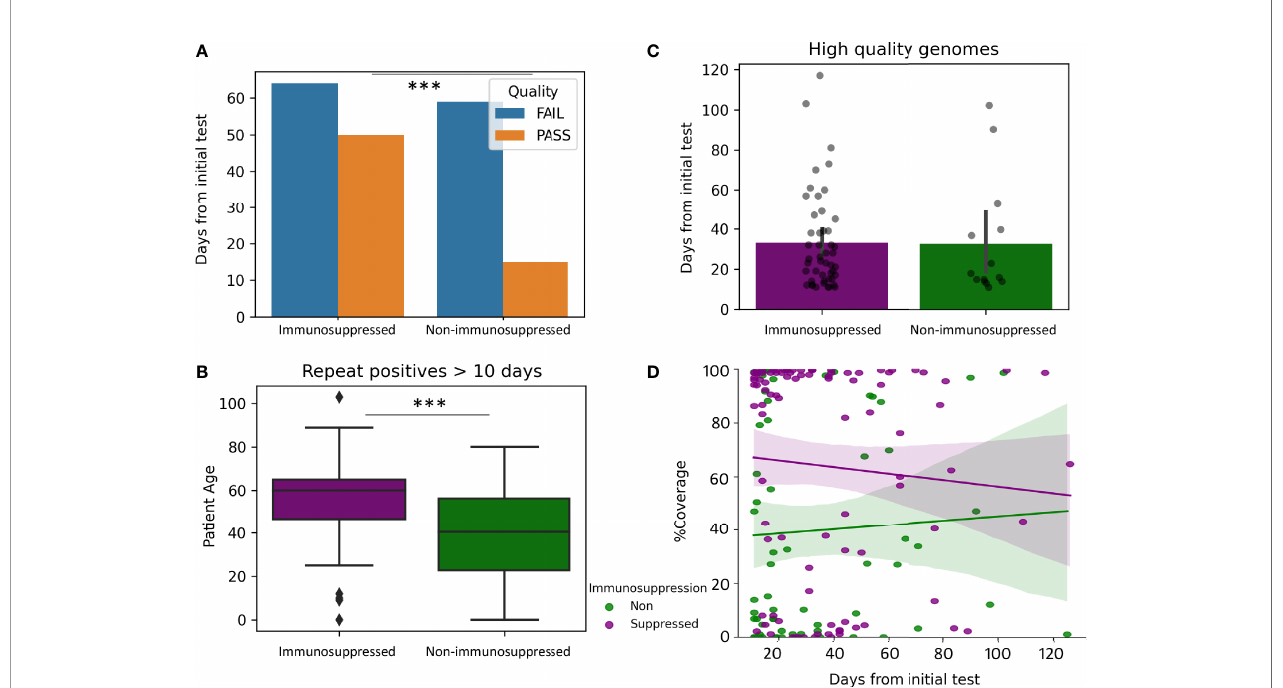
FIGURE 4 | Impact of Immunosuppression on prolonged viral shedding. Genomes from repeat positive samples within the fi rst 130 days after the initial positives (N = 114 immunosuppressed and 74 non-immunosuppressed). (A) Quality of genomes in samples from immunosuppressed and non-immunosuppressed patients. (B) Boxplot of patient age in samples from immunosuppressed (Median 60 years) and non-immunosuppressed (median 40.5 years). (C) Barplots with overlayed strip plots of the recovery of high-quality genomes compared in relation to days after the fi rst positive. (D) Implots of genome coverage compared to days from the initial positive in immunosuppressed and non-immunosuppressed patients. ***p <